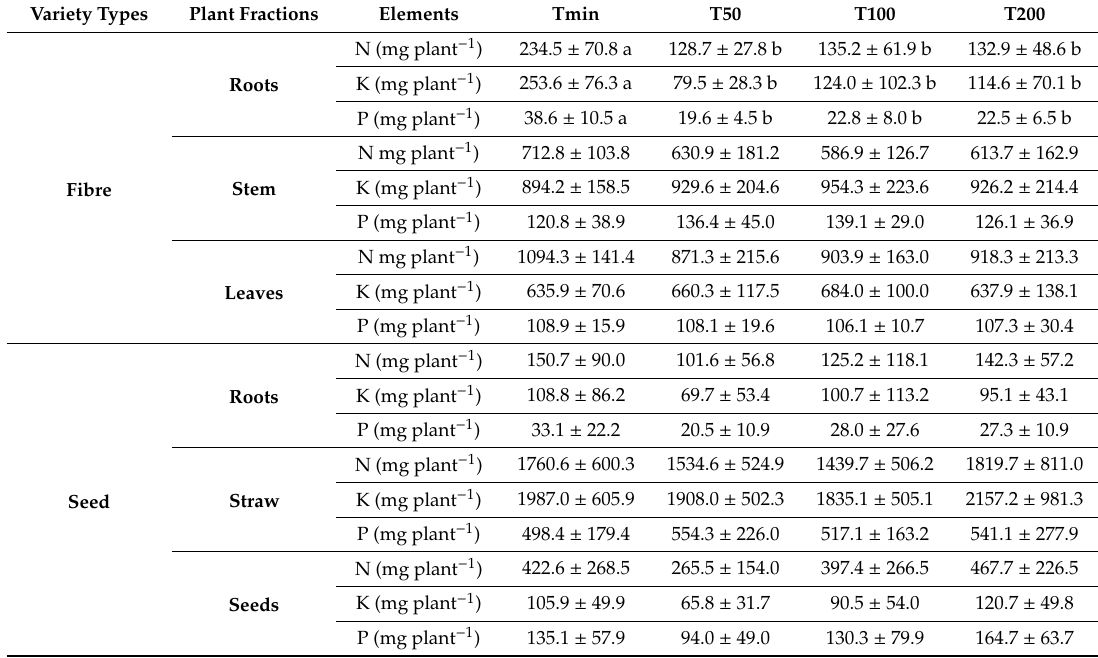
Table 3. Macronutrient uptake in the hemp